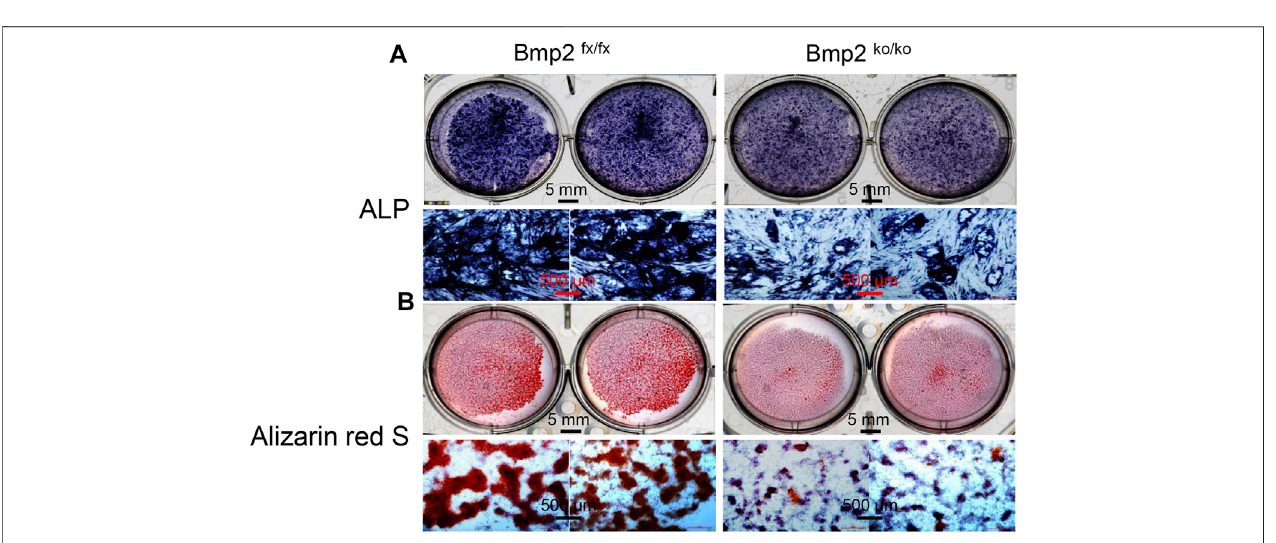
FIGURE 1 | Deletion of Bmp2 delays mouse dental papilla cell differentiation and mineralization. (A) iBmp2 fx/fx and iBmp2 ko/ko cells were cultured in the calcifying medium for 7 days. ALP activity was analyzed using in situ ALP staining. (B) For cell mineralization assay, both the iBmp2 fx/fx and iBmp2 ko/ko cells were treated with the calcifying medium for 10 days. Mineralized nodules were visualized with Alizarin Red S staining. fx, fl oxed; ko, knock-out.